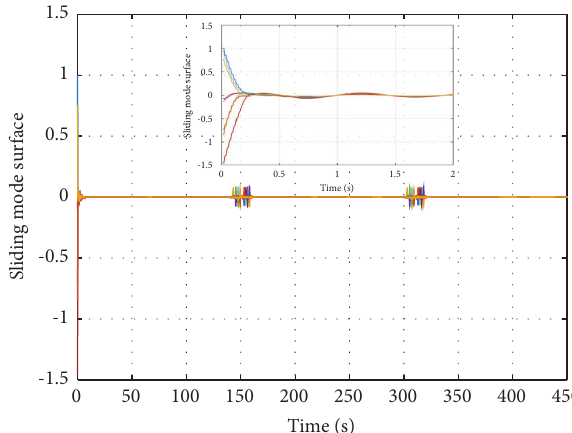
Figure 6: The evolution of the sliding mode surface S